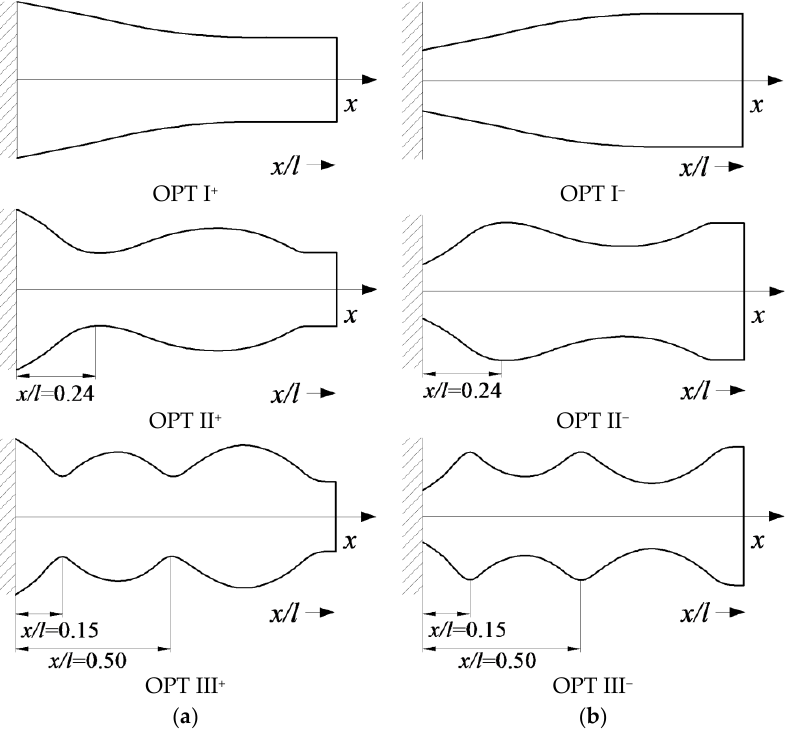
Figure 1. Optimal cantilever structures for the operation at increased ( a ) and reduced ( b ) natural frequencies of transverse vibrations (from top to bottom: the 1st (OPT I), the 2nd (OPT II) and the 3rd (OPT III) natural frequencies).